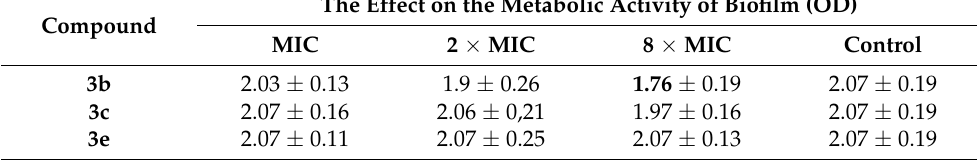
Table 5. The effect of compounds on the metabolic activity of mature C. albicans biofilm (with XTT reduction assay). The Effect on the Metabolic Activity of Biofilm (OD) Compound MIC